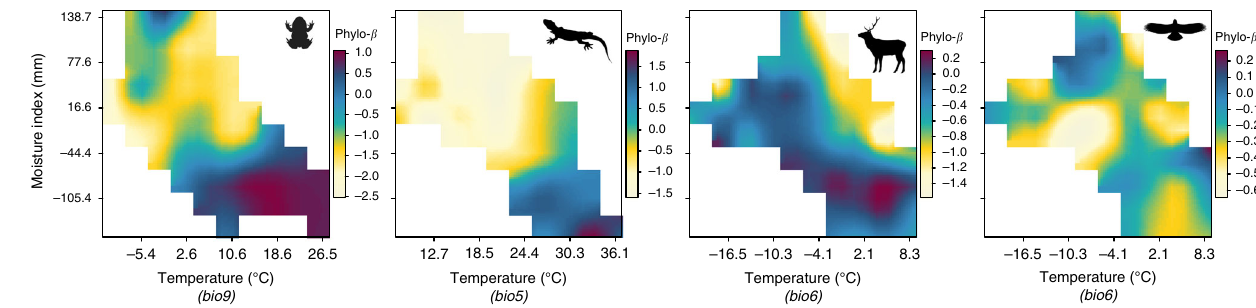
Fig. 2 True phylogenetic turnover in environmental space. Phylo- ß is illustrated for amphibians, squamates, mammals, and birds (from left to right) and is corrected for geographic land distance between sites (see Method). Environmental space is de fi ned by moisture index and temperature (represented by bioclim variables 60 , selected for each clade based on their highest explanatory power: bio9 = mean temperature of driest quarter, bio5 = maximum temperature of the warmest month, bio6 = minimum temperature of the coldest month). Silhouette images were taken unchanged from phylopic.org, courtesy of Pedro de Siracusa (amphibians), Ghedo and T. Michael Keesey (squamates) both available under CC BY-SA 3.0 (creativecommons.org/ licenses/by-sa/3.0/), Steven Traver (mammals) available under CC0 1.0 (creativecommons.org/publicdomain/zero/1.0/), and Shyamal (birds)